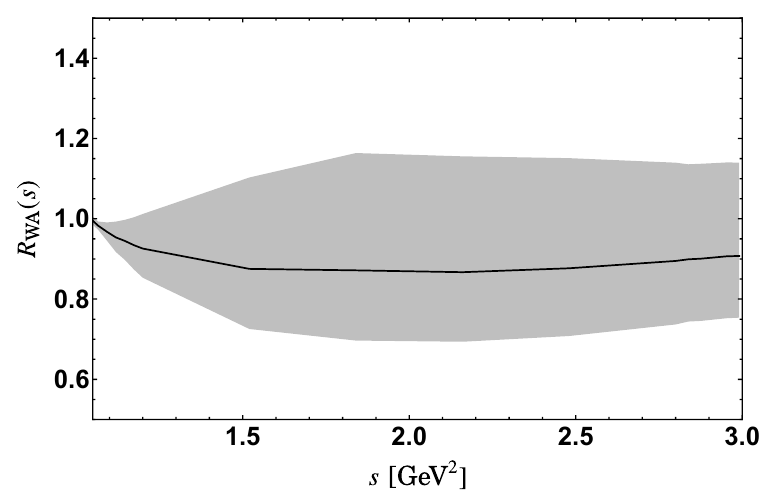
Figure 5 . Ratio of the differential branching ratios obtained with and without the weak annihi- lation contribution, as defined in eq. (4.21). The shaded error band is determined as explained in section